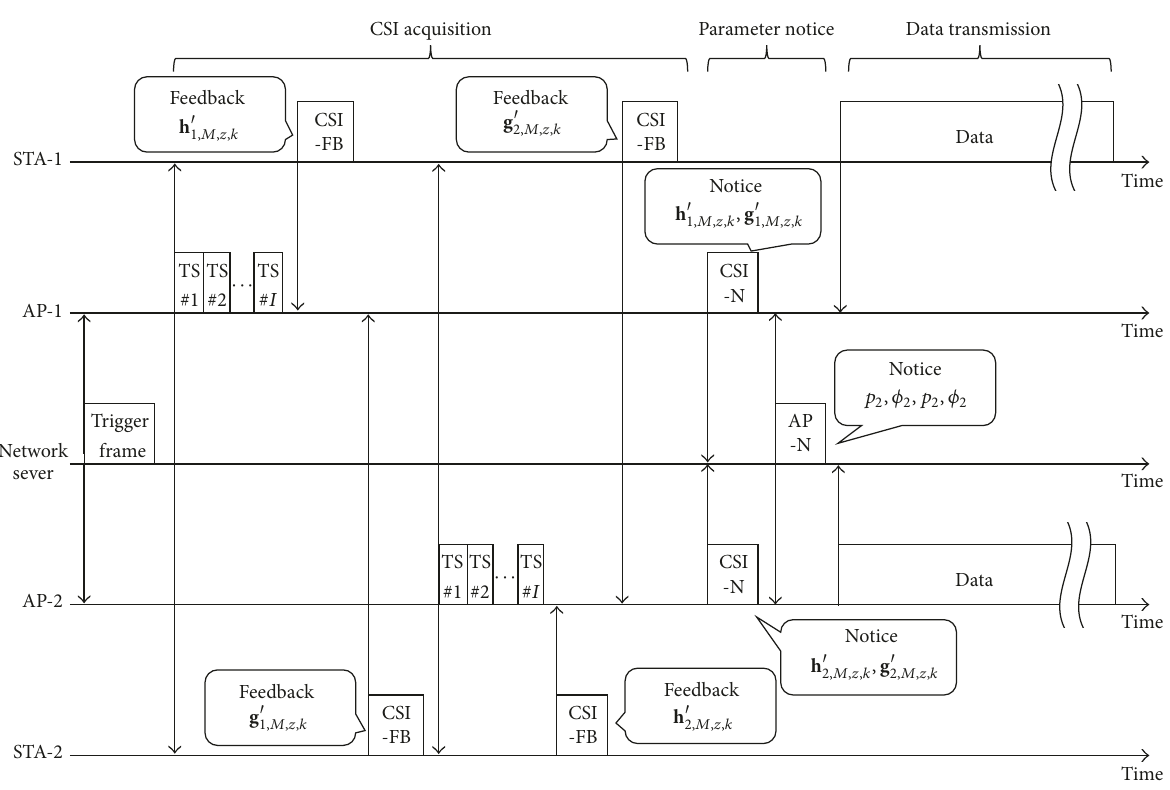
Figure 3: Frame sequence.